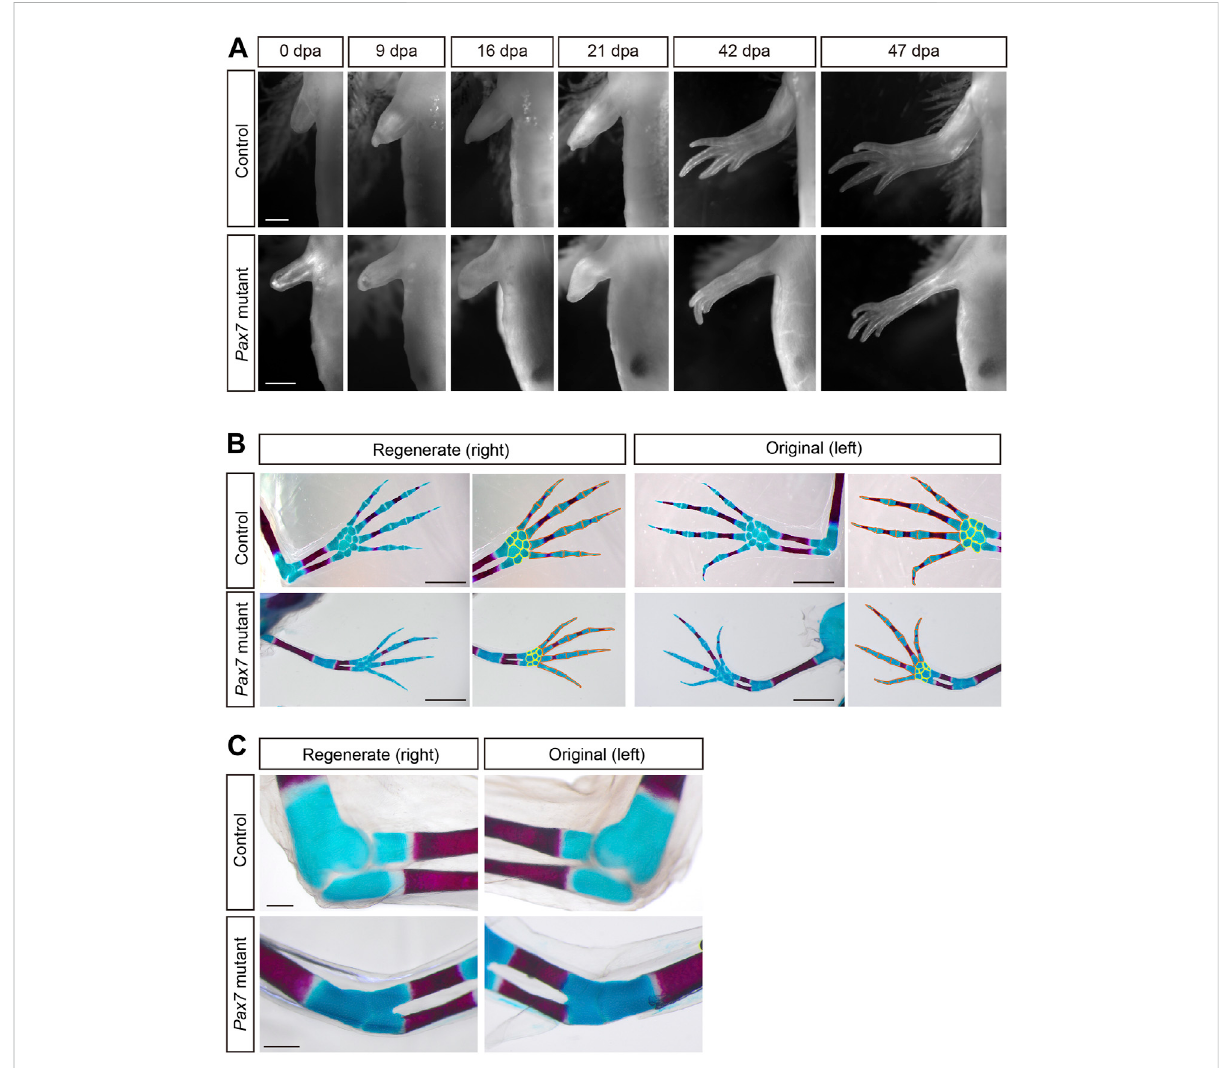
FIGURE 1 Morphology and patterning of limb regenerates in Pax7 mutants. (A) Bright- fi eld images of the limbs at indicated dpa, from 3-month-old controls and Pax7 mutants. Scale bars, 1 mm. (B) Alcian blue and Alizarin red-stained fully regenerated (left panels) and un-operated (right panels) forelimbs from controls (upper panels) and Pax7 mutants (lower panels).Amputations werecarried out on 6-month-old animals, then allowed them to regenerate for 10-months for analysis. Hand part of each stained forelimb is presented at higher magni fi cation, in which the red and yellow lines outline the phalange, metacarpal bones and carpal bones, respectively. Scale bars, 2 mm. (C) The elbow joint of regenerated (left panels) and un-operated (right panels) forelimbs from controls (upper panels) and Pax7 mutants (lower panels). Scale bars, 500 μ